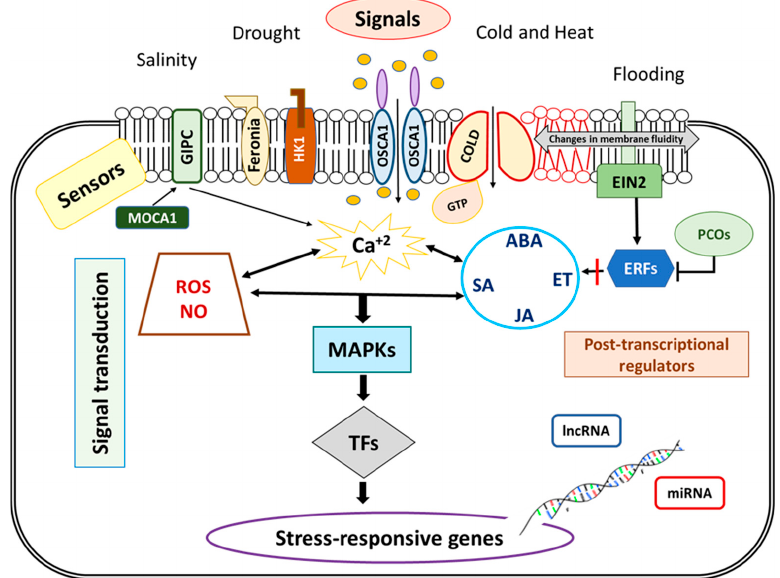
Figure 3. Abiotic stress signaling in roots. To activate adaptative responses, in a first step environmental signals should be detected by sensors located at plasma membrane (as ion channels and other transporters, membrane-anchored receptor like kinases). Then, second messengers (Ca +2 , inositol phosphate and Reactive Oxygen Species, ROS) amplify signals, and, in coordination with phytohormones (Abscisic Acid, ABA; Salicylic Acid, SA; Jasmonic Acid, JA, and Ethylene, ET) activate Mitogen-Activated Protein Kinases (MAPKs) signaling pathways and transcription factors (TFs) that